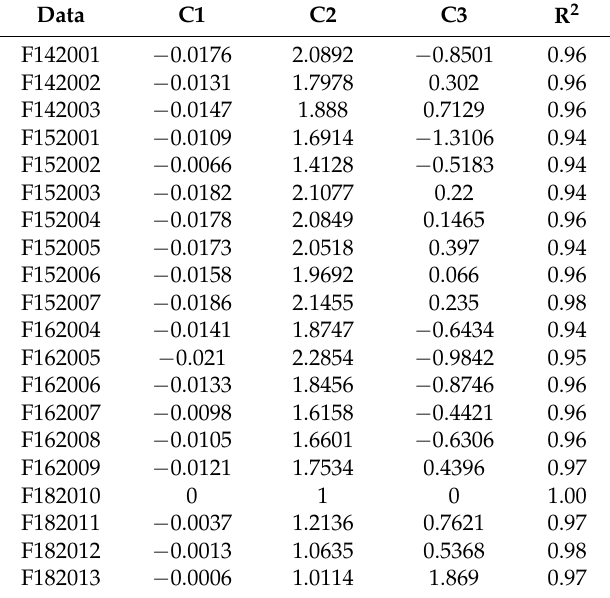
Table 1. The coefficients of calibration equations for intercalibrating the stable nighttime light (SNLD)